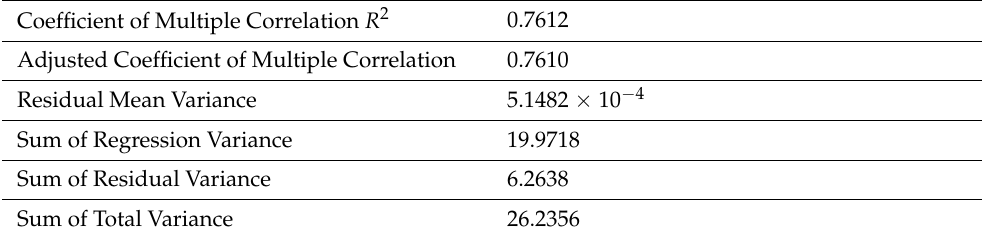
Table 4. Validity Parameter Values for the Experimental Model of Equation